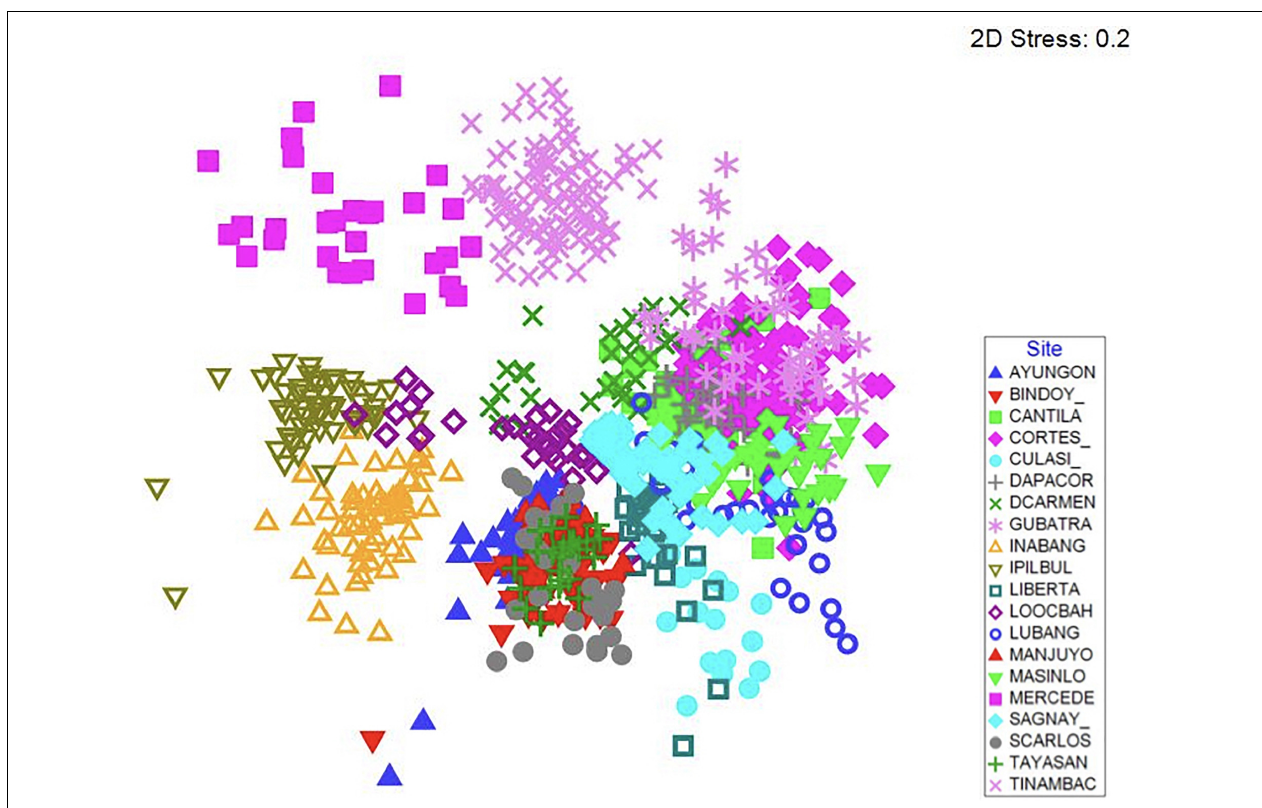
FIGURE 2 | Non-metric multidimensional scaling (nMDS) plot of fish species community structure of all sites. Symbols indicate site.